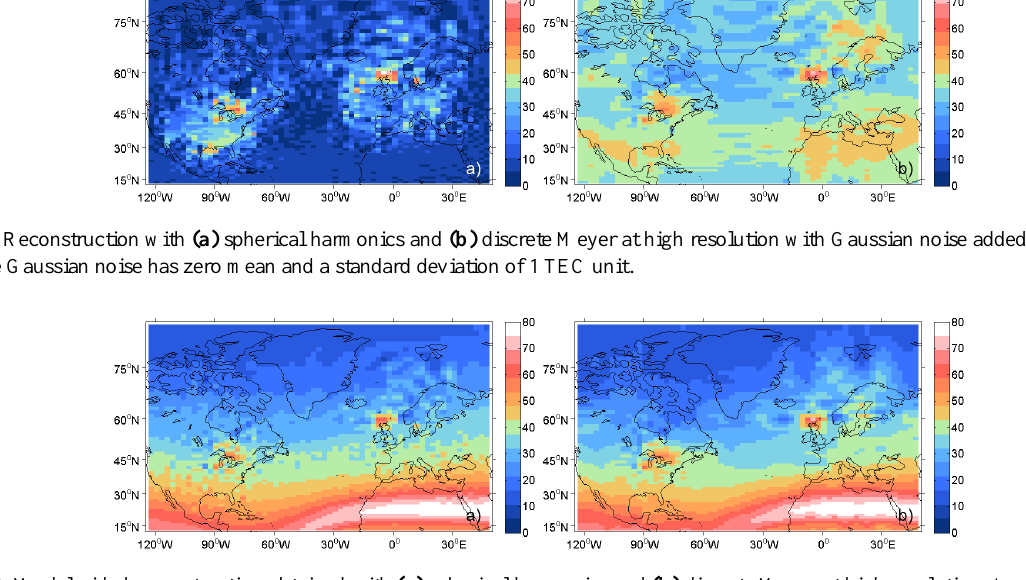
Figure 10. Model-aided reconstruction obtained with (a) spherical harmonics and (b) discrete Meyer at high resolution. A noise term (zero- mean Gaussian with 1TEC unit of standard deviation) was added to the observations.